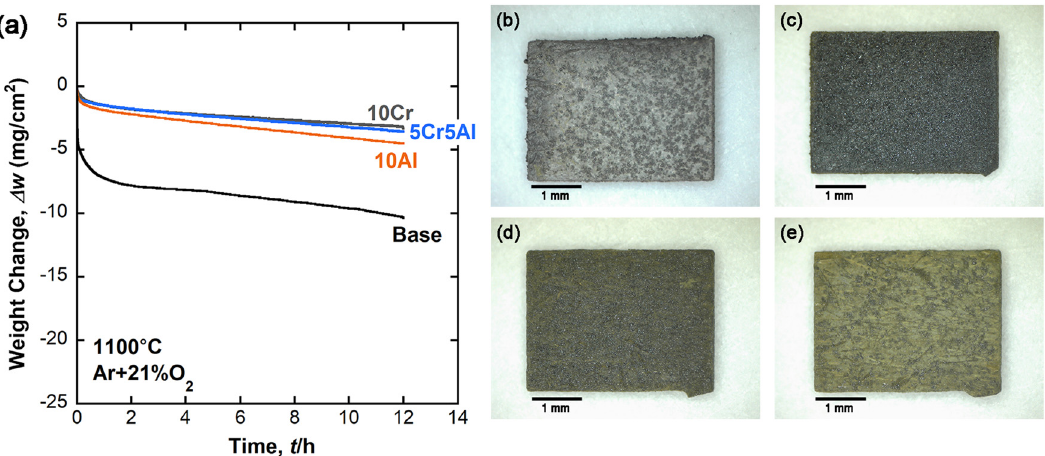
Figure 7: ( a ) Isothermal oxidation curves of the alloys obtained at 1,100°C and the appearance of the ( b ) base, ( c ) 10Cr, ( d ) 5Cr5Al and ( e ) 10Al specimens oxidized for 12